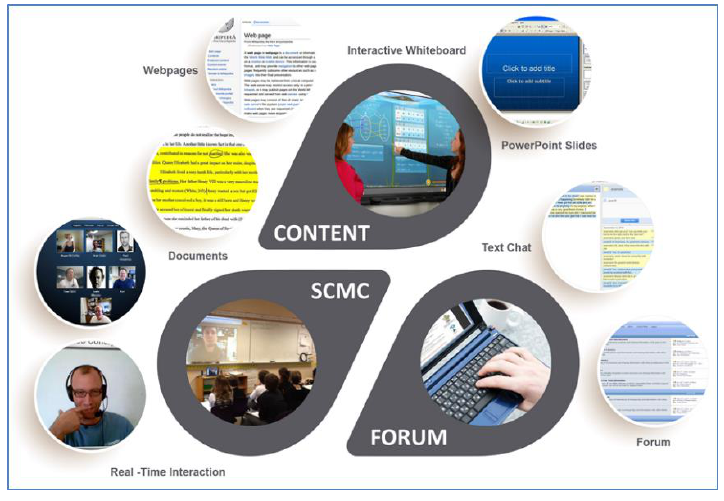
Figure 1: Components of the online Masters